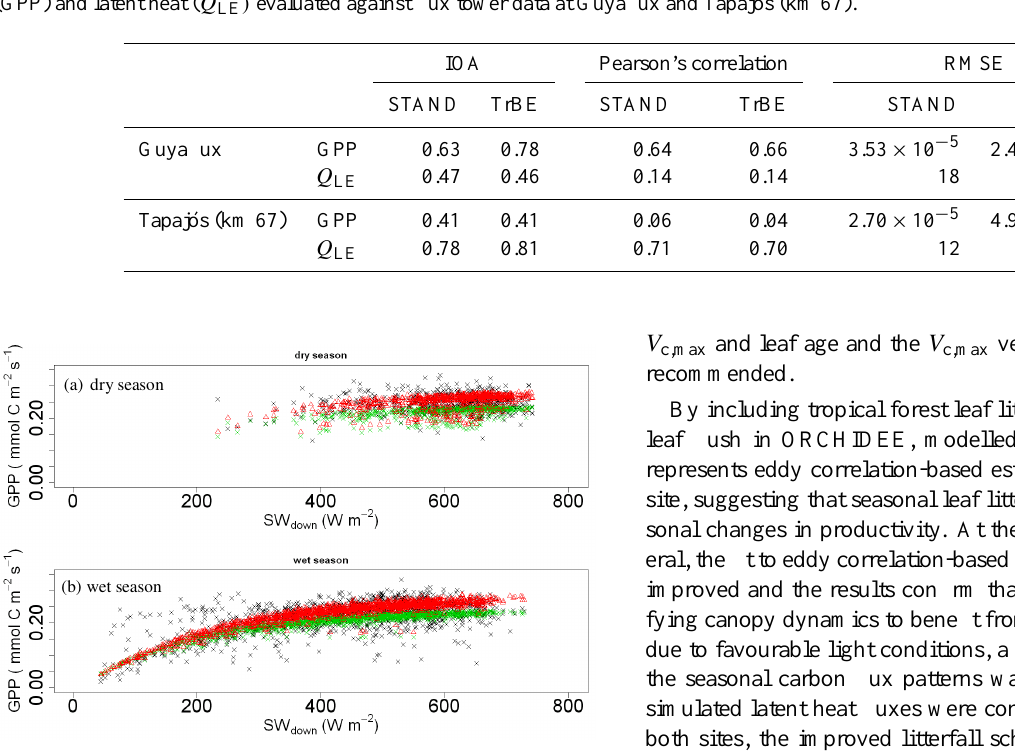
Fig. 10. The relationship at Guyaflux between GPP Figure 10. The relationship at Guyaflux between GPP (mmol C m -2 s -1 ) fluxtower data (mmolCm − 2 s − 1 ) flux tower data (black), ORCHIDEE model (black), ORCHIDEE model outputs from the standard version (green) and the modified outputs from the standard version (green) and the modified ORCHIDEE-TrBE version (red) and SW down (Wm -2 ) from 2004 until 2009. Models are ORCHIDEE-TrBE version (red) and SW down (Wm − 2 ) from 2004 plotted for dry season (a) and wet season (b) (threshold monthly rainfall > 100mm); daily until 2009. Models are plotted for dry season (a) and wet season (b) means are calculated from daytime (8h-16h) data, hours with extreme rainfall (>40 mm/h) (threshold monthly rainfall > 100mm); daily means are calculated were omitted. from daytime (08:00h–16:00h) data; hours with extreme rainfall ( > 40mmh − 1 ) were